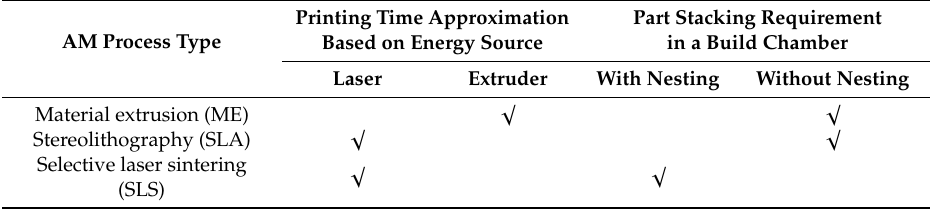
Table 1. AM printing time and part nesting